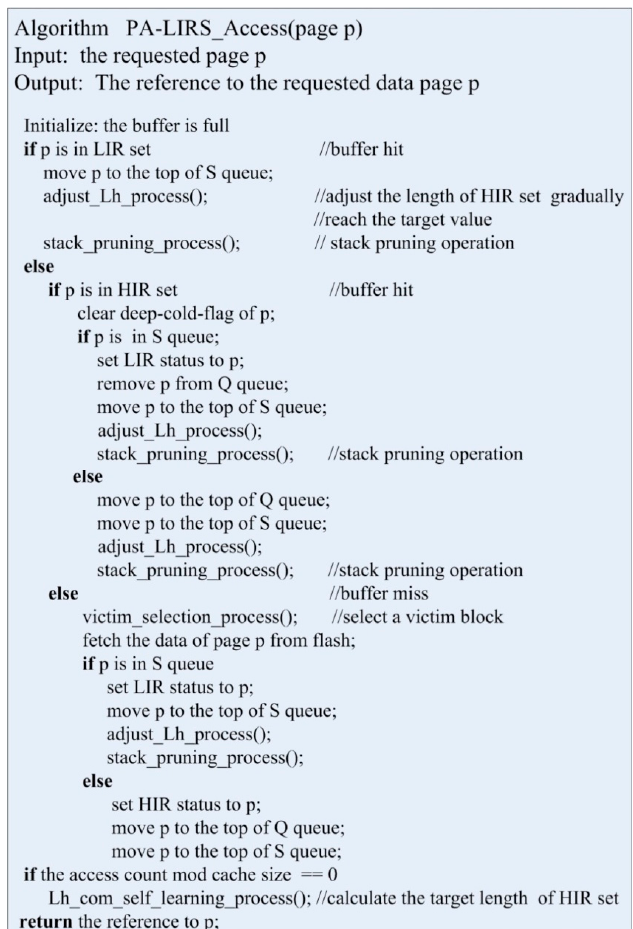
Figure 5. The pseudo-codes of the page management algorithm of PA-LIRS.